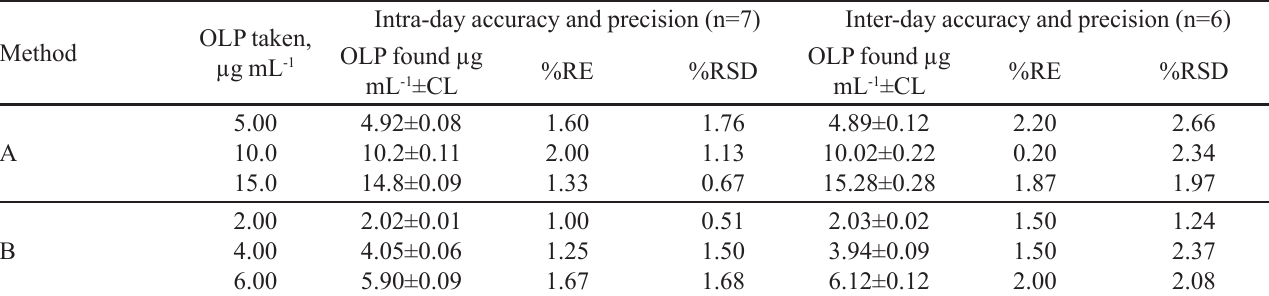
TABLE III - Evaluation of accuracy and